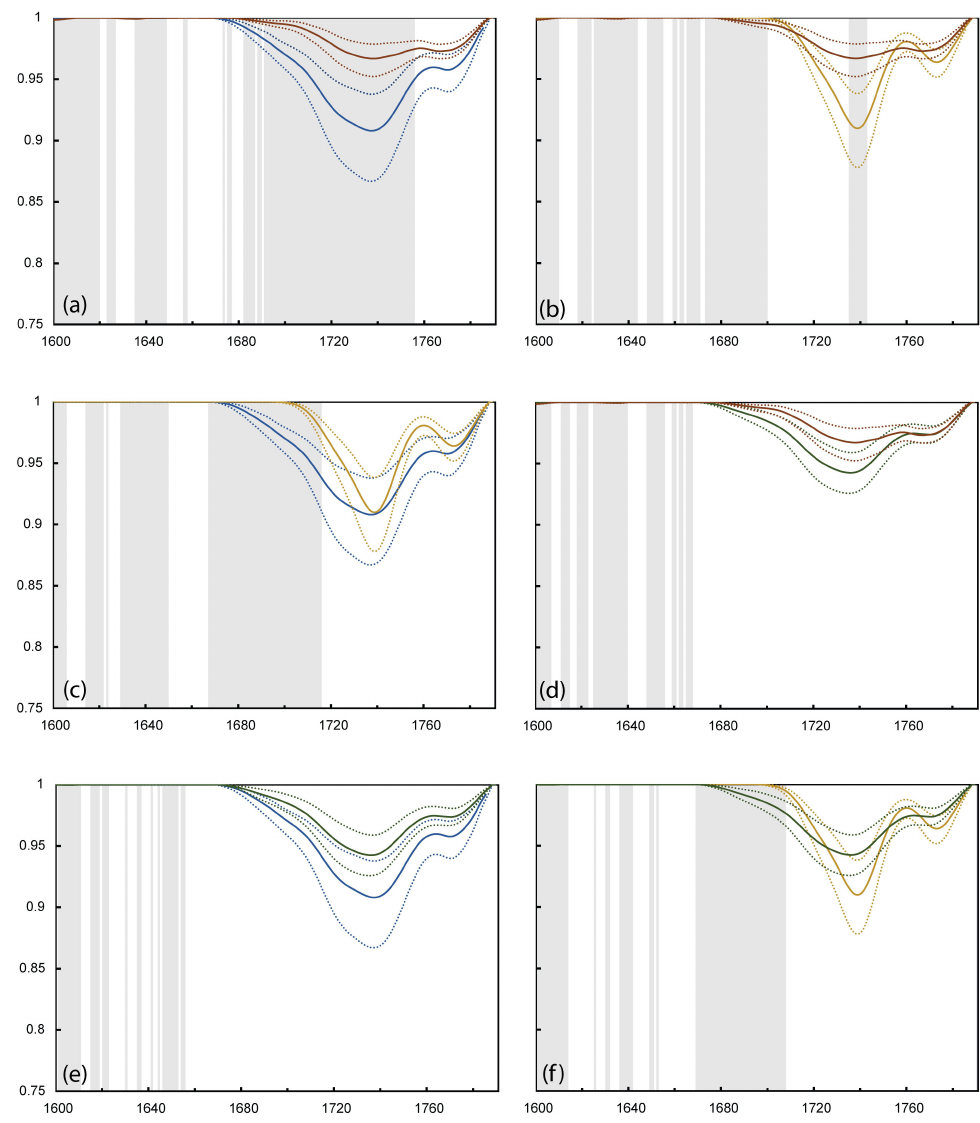
Figure 9. Continuum-removed reflectance of quadrats that were statistically different from sand spectra around 1732 nm, compared to each other. The mean and 95% upper and lower confidence intervals are shown for the MPD contaminated quadrats in each graph (in colour). Sample pairings are ( a ) 1.56% and 3.43% ( b ) 1.56% and 4.88% ( c ) 3.43% and 4.88% ( d ) 1.56% and 7.94% ( e ) 3.43% and 7.94% and ( f ) 4.88% and